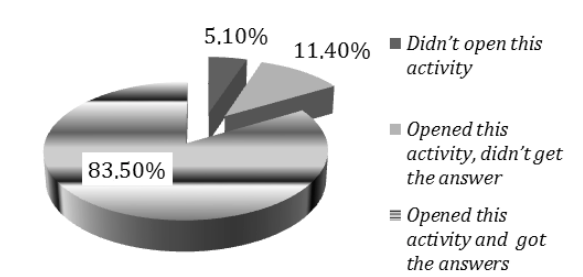
Figure 6. Students' interest in the applicability of mathematics